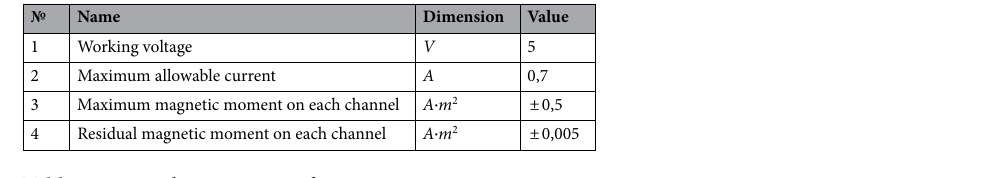
Table 2. Main characteristics of magnetic